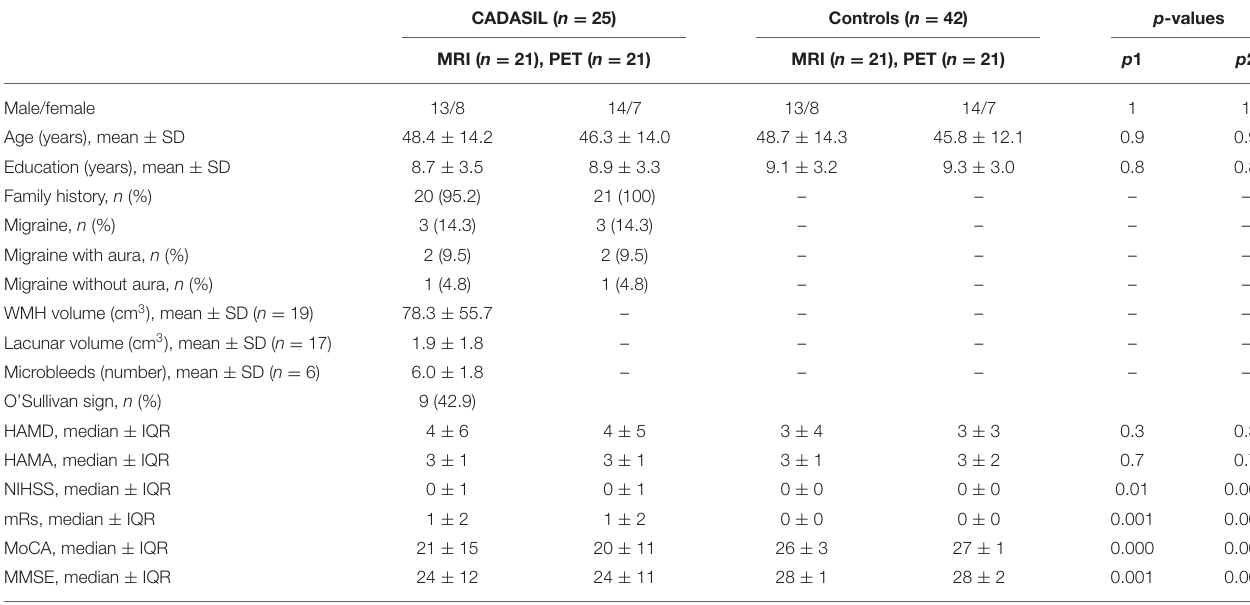
TABLE 1 | Demographic information of CADASIL and control.